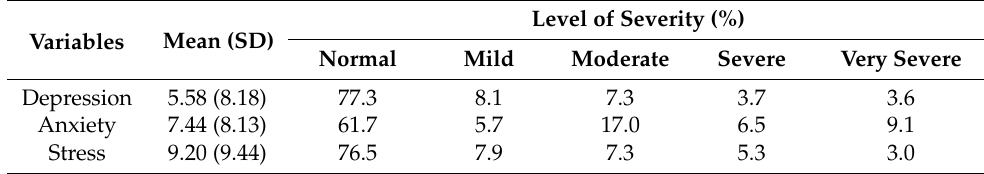
Table 3. DASS-21 Dimensional Scores and Prevalence of Depression, Anxiety, and Stress ( n = 507). Variables